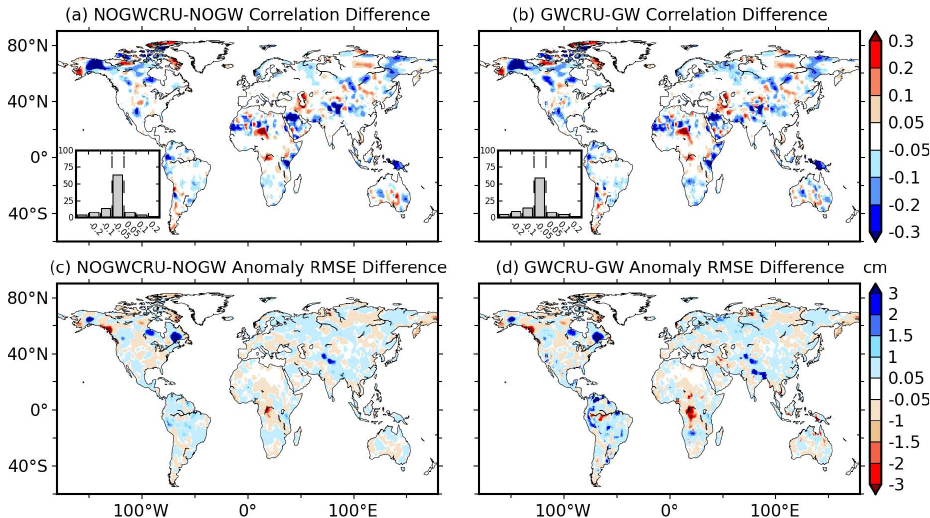
Fig. 11. Score differences between the CRU and GPCC simulated TWS. Correlation differences are shown (a) without and (b) with ground- water, together with monthly anomaly RMSE differences (c) without and (d) with groundwater. Histogram (in %) of correlation differences are also shown in (a) and (b)